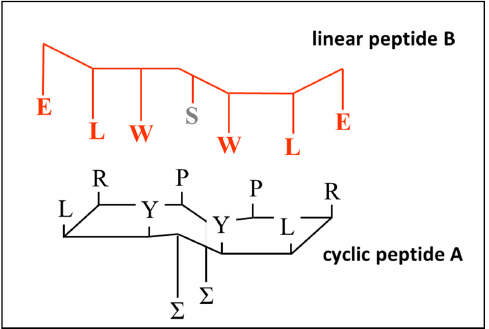
Figure 4. Sequence structure of the cyclic peptide aptamer ( A ) and linear peptide ( B ) employed in this study.